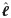
Evolution of ℓ^ on whitened natural image patches when using advanced training methods.GRBM-196-196s were trained on the whitened natural image data set using CD-10, PCD-10, and PT-10 with 10 linearly distributed inverse temperatures. The learning curves are averaged over 10 trials. The gradient was restricted to one hundredth of the maximal data norm (0.48) and the learning rate for the variance parameter was set 100 times smaller than for the other parameters.